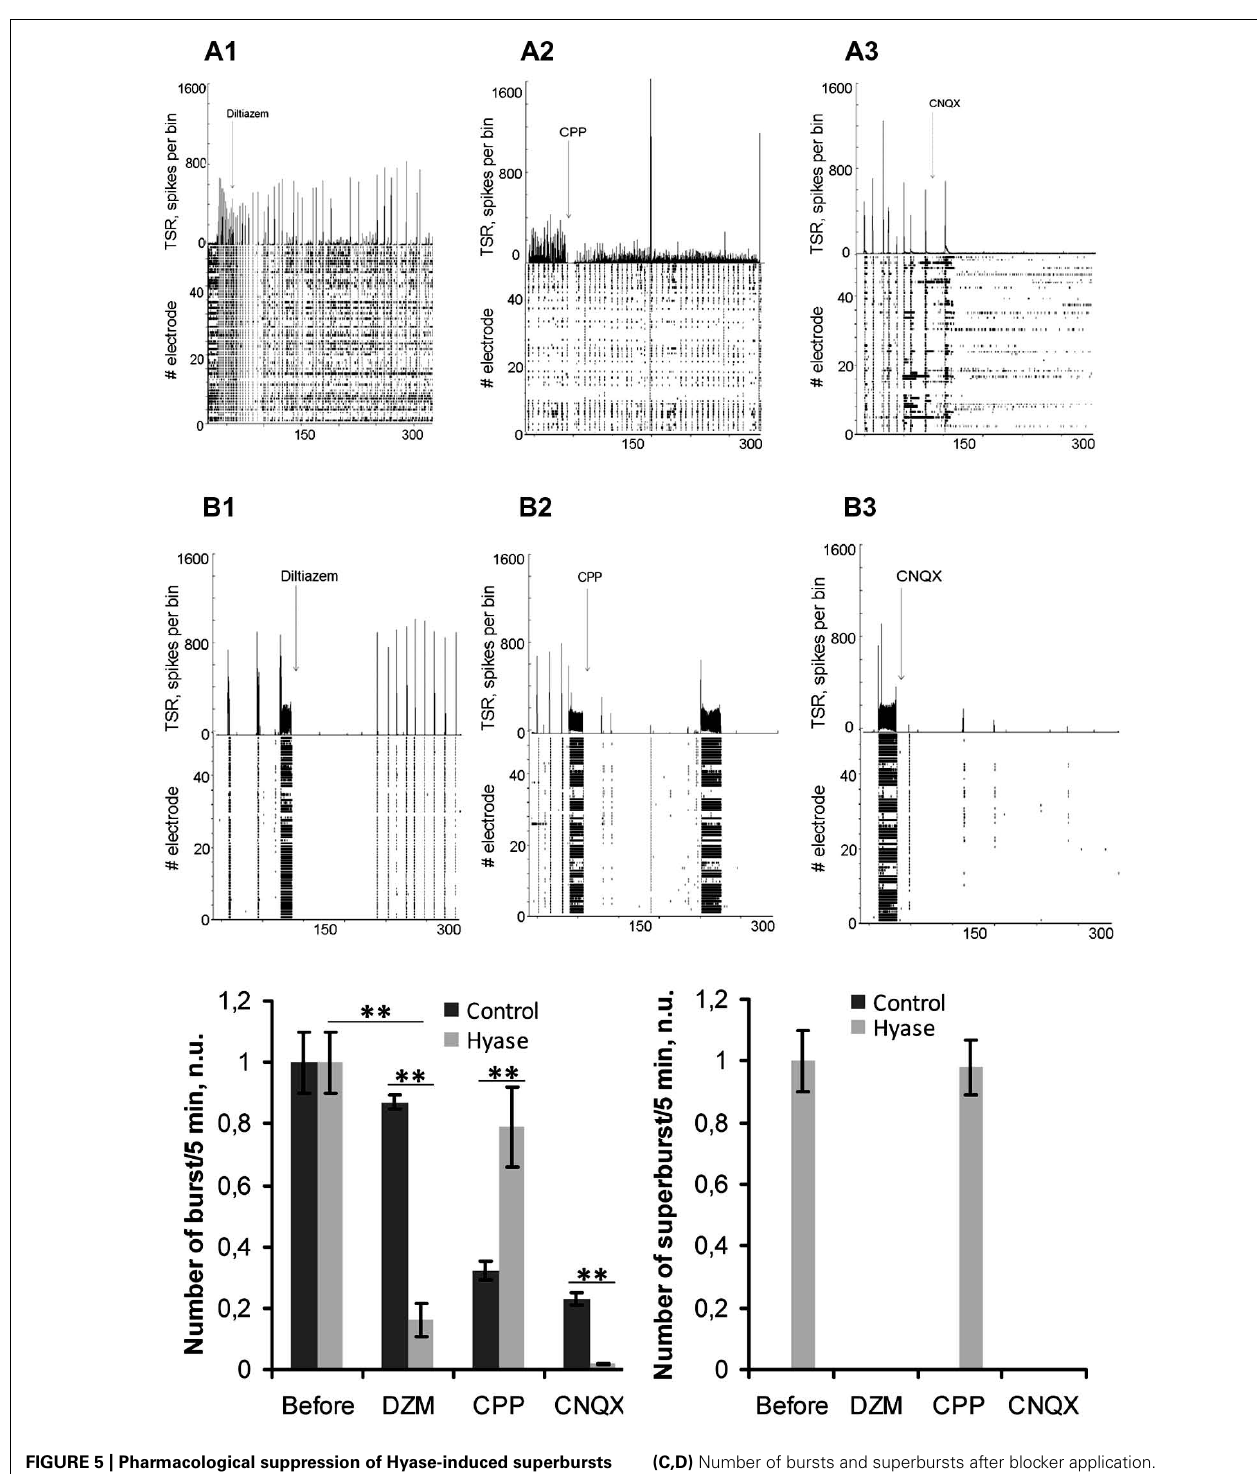
(C,D) Number of bursts and superbursts after blocker application. CPP: ( ± )-3-(2-carboxypiperazin-4-yl)propyl-1-phosphonic acid, 10 μ Ì; CNQX, 6-Cyano-7-nitroquinoxaline-2,3-dione, 10 μ Ì; Hyase, hyaluronidase; DZM, diltiazem, 10 μ M. Mean ± SEM are shown, ** p < 0.001 indicate significant differences by ANOVA, N =